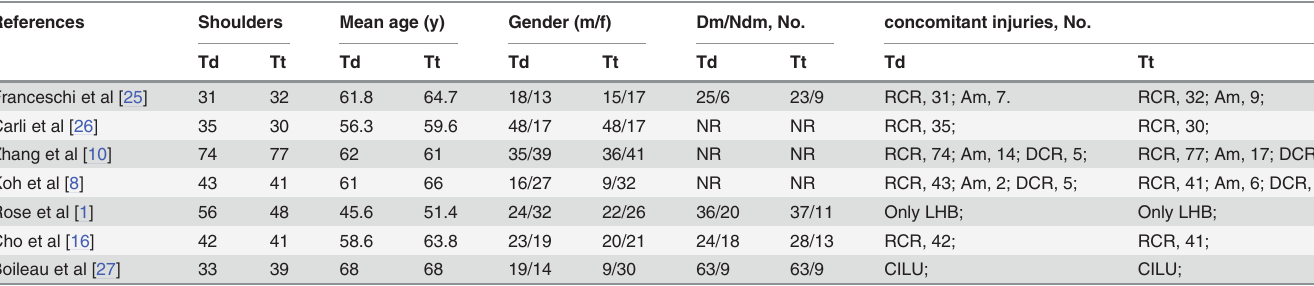
Table 2. Patient characteristics of the included studies.